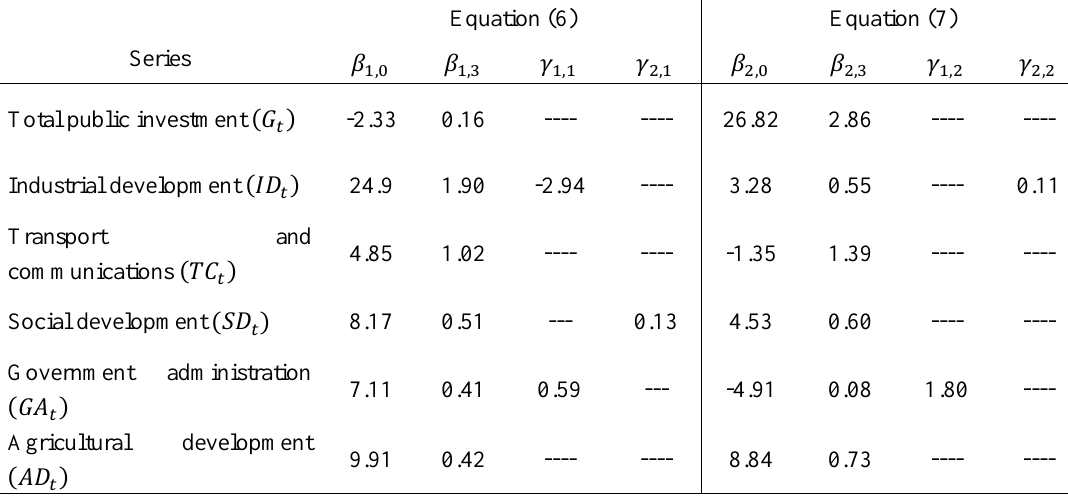
Table 5 : Estimated parameters of normalized